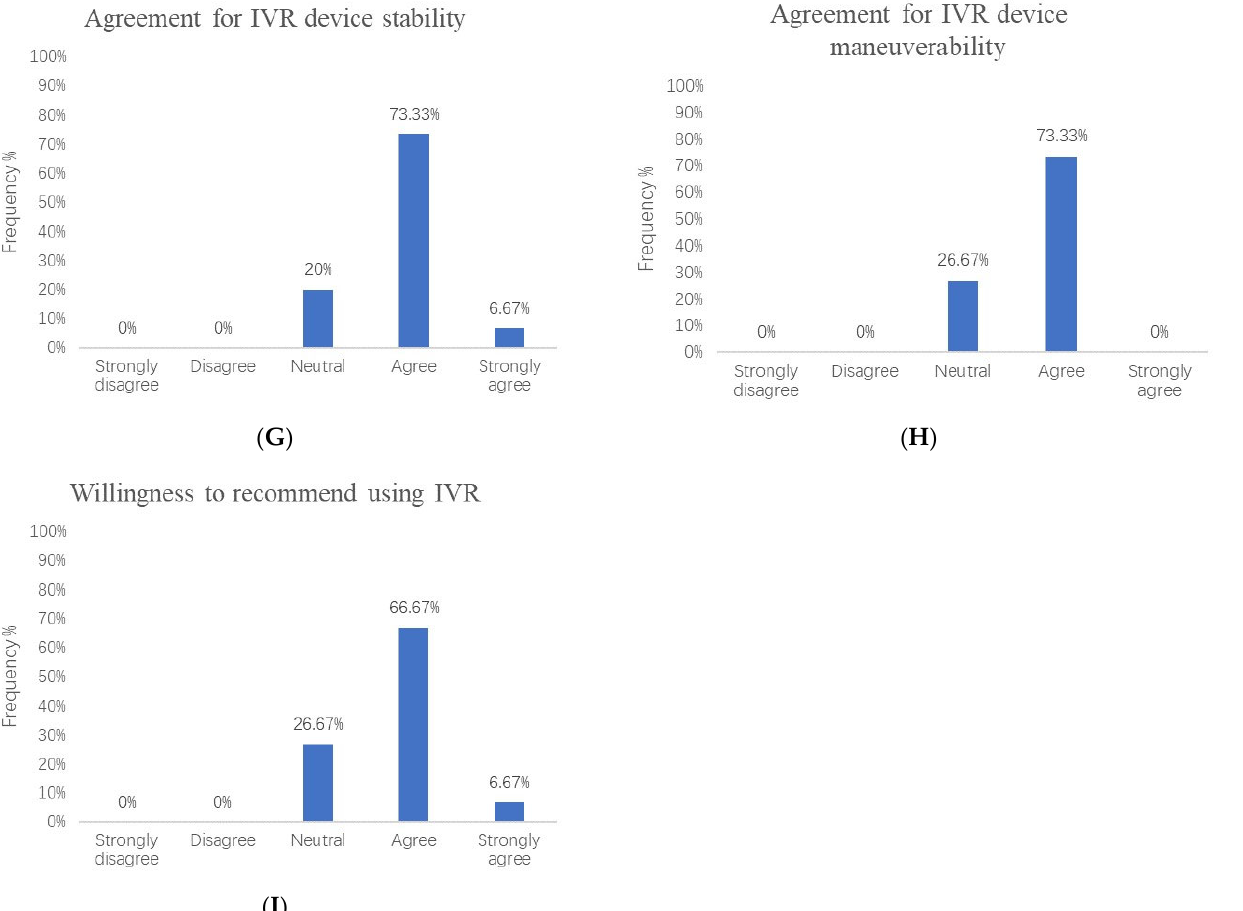
Figure 5. Histograms ( A – C ) depict the frequency of smart device usage experienced and the willingness to accept smart devices by the IVR group. Histograms ( D – I ) depict satisfaction with IVR equipment and training contents experience. PAD, portable android device; IVR, immersive virtual reality.